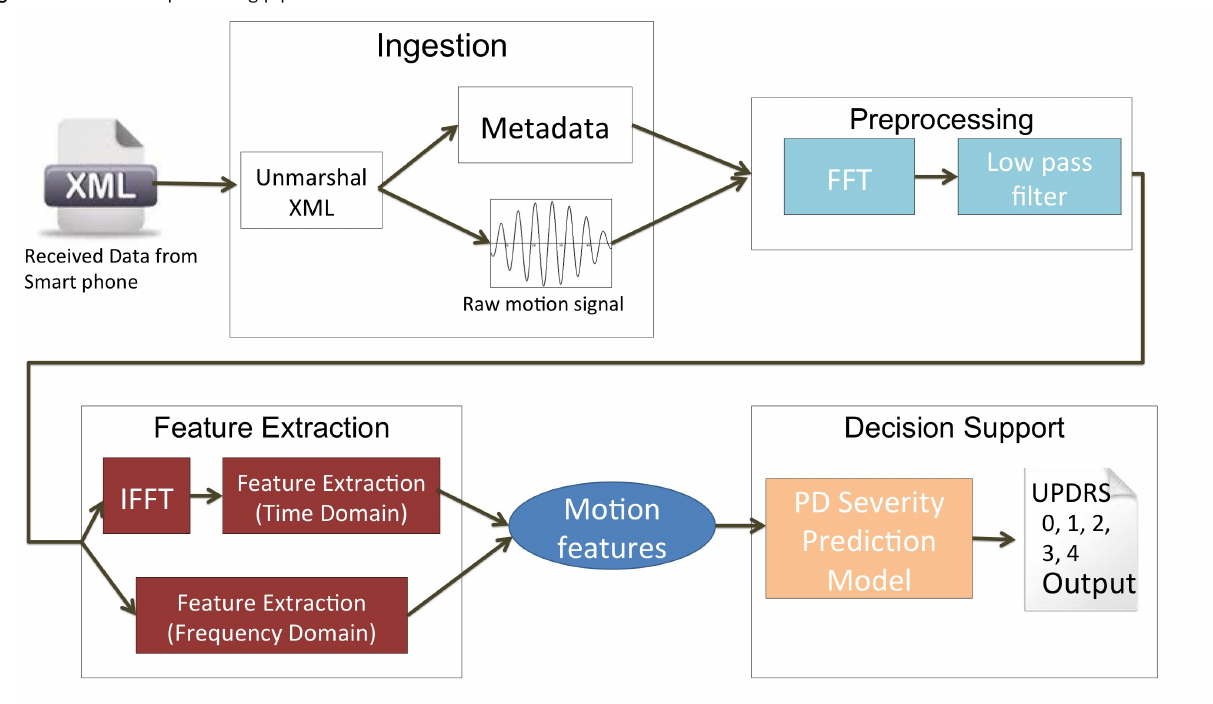
Figure 4. Cloud data processing